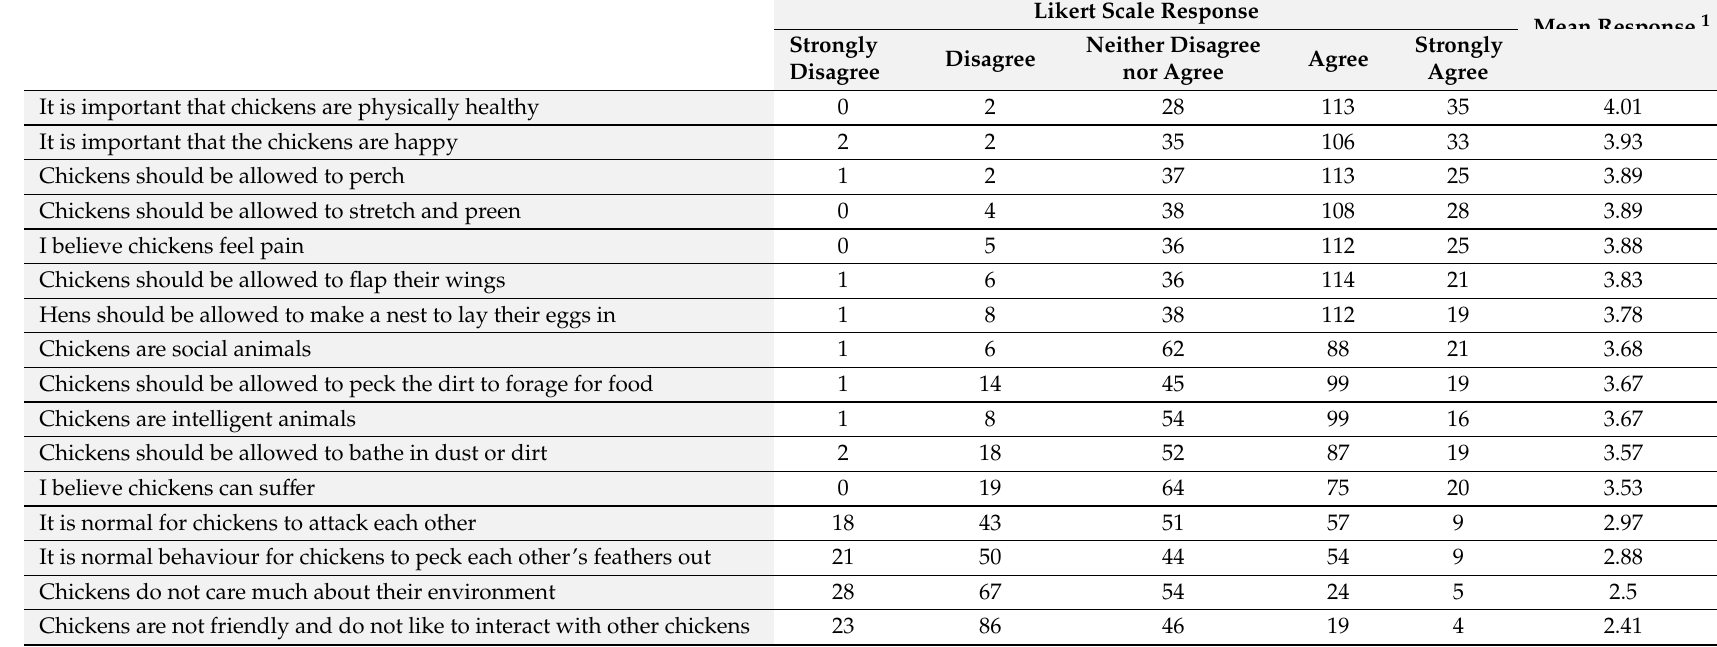
Table 5. Attitude towards chickens and their behaviour, with di ff erences between mean